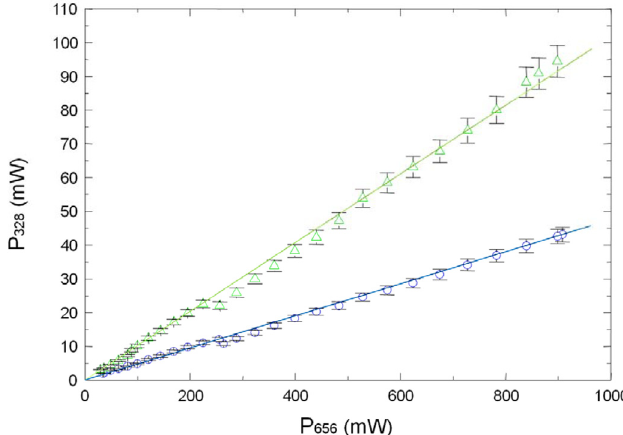
Fig. 4. (Color online) SHG conversion efficiencies in a β - BaB 2 O 4 crystal for a waist value of ω 0 = 43 . 9 μ m ( ◦ ) and of ω 0 = 21 . 8 μ m ( (cid:5)